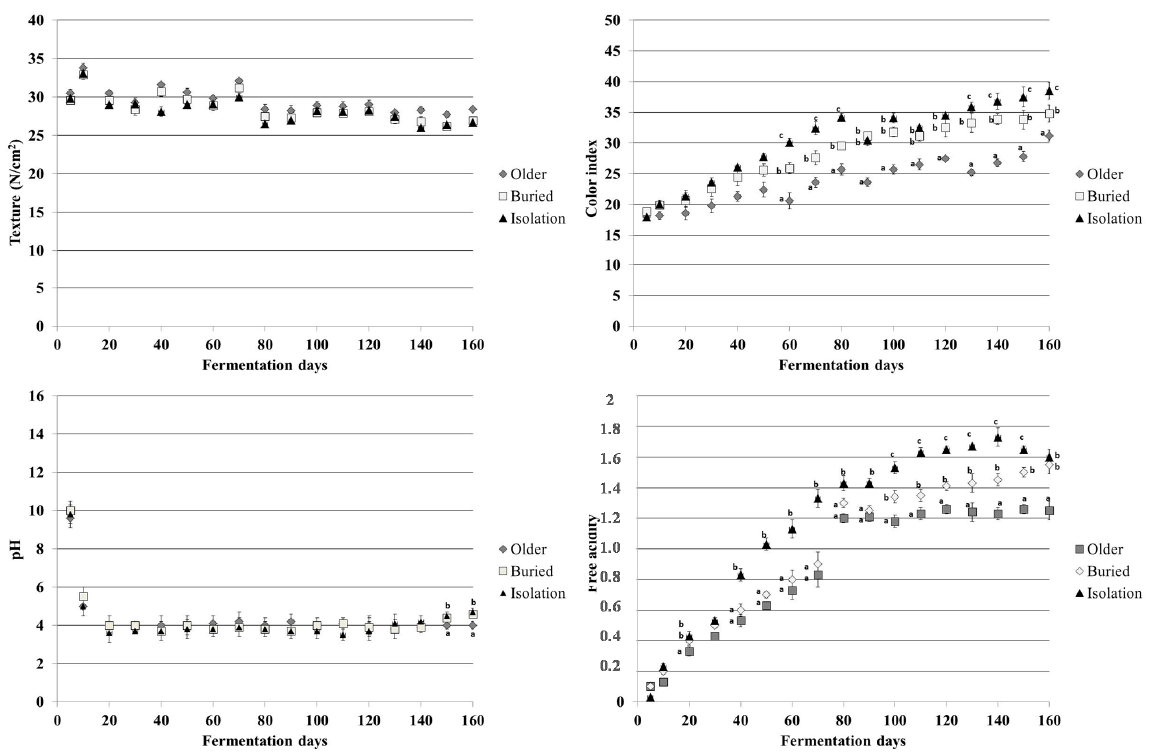
(C) Manzanilla de Sevilla olives fermenters with different heat control capacities. Older: low capacity; Buried: fer- menters located beneath the floor; Isolation: winter resistant (experiment 3).